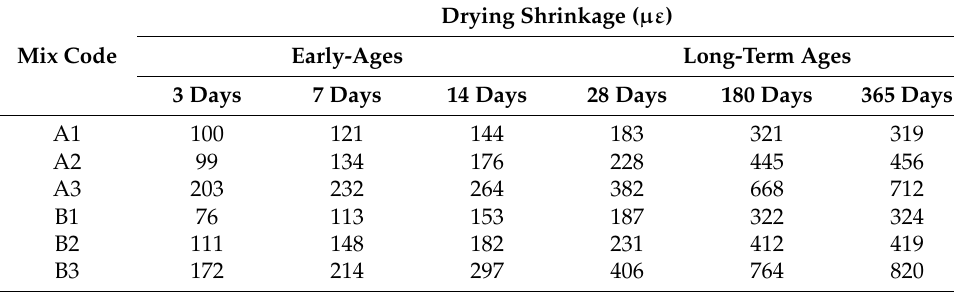
Table 9. Drying shrinkage results under the non-curing